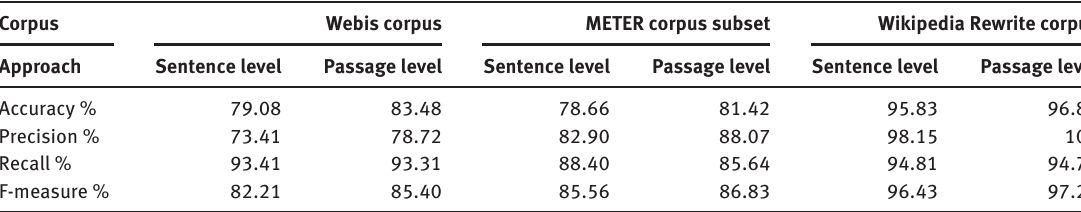
Table 2: Performance of Sentence-Level and Passage-Level Approaches. Corpus Webis